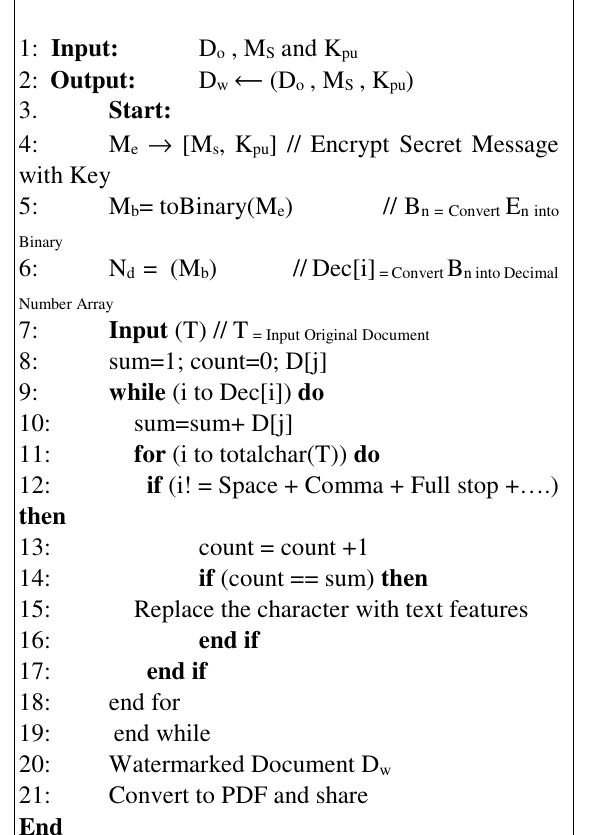
Algorithm III: Third Level Watermark Embedding